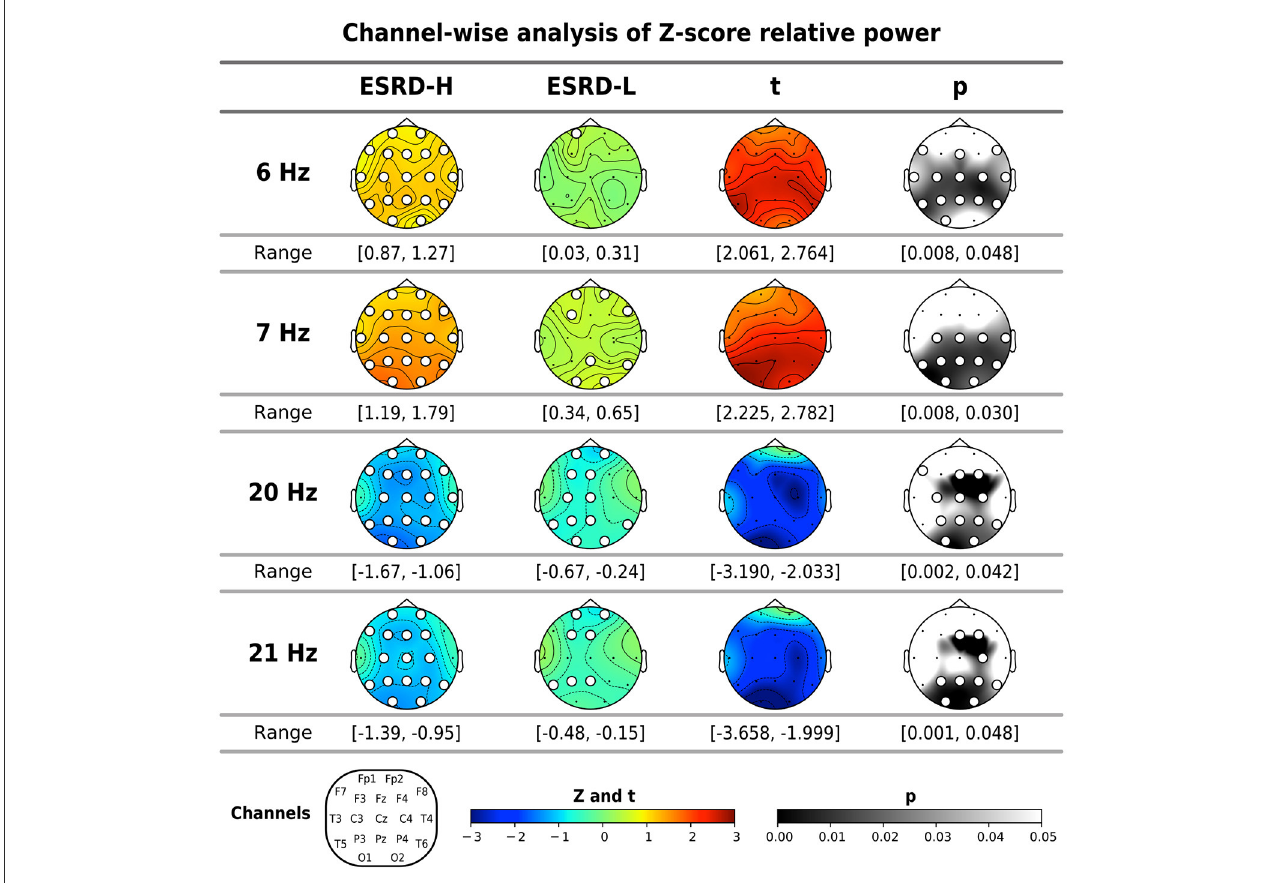
FIGURE2 The significant frequencies (6, 7, 20, and 21 Hz) according to the global mean analysis of the Z-score FFT relative powers were determined through channel-wise comparisons between subject groups and comparisons to zero (mean of normative data) by using permutation-based t -tests and one-sample permutation tests. The white dots indicate significant channels in the map. All values are represented by color bars and described in the closed interval, except the t - and p -values, which indicate significant